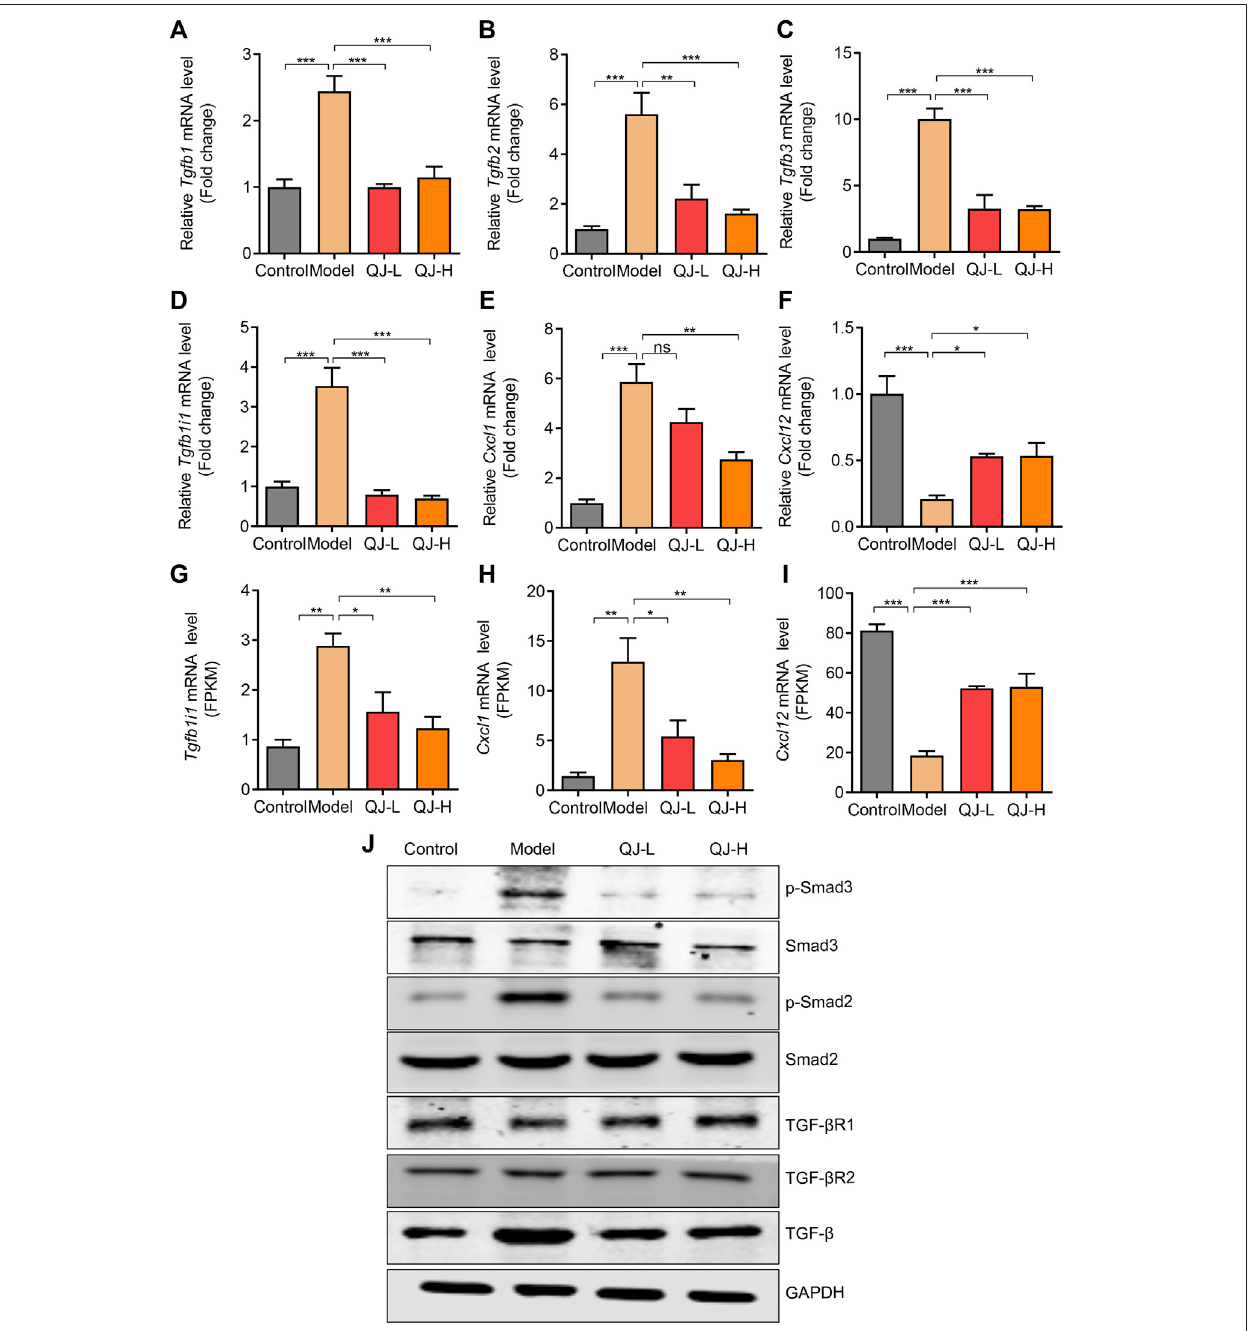
FIGURE 8 | Validation of the expression of mRNA and proteins. (A – F) qRT-PCR validations of related genes ( n = 4); (A) Tgfb1 : transforming growth factor beta 1; (B) Tgfb2 : transforming growth factor, beta 2; (C) Tgfb3 : transforming growth factor beta 3; (D) Tgfb1i1 : transforming growth factor beta 1 – induced transcript 1; (E) Cxcl1 :C-X-Cmotifchemokine ligand1; (F) Cxcl12 :C-X-C motif chemokine ligand12; (G – I) Bulk RNA-seq analysisoftheexpression levelof Tgfb1i1 , Cxcl1 ,and Cxcl12 ( n = 3); (J) Representative Western blotting was performed to detect the levels of p-Smad3, Smad3, p-Smad2, Smad2, TGF- β R1, TGF- β R2, and TGF- β .